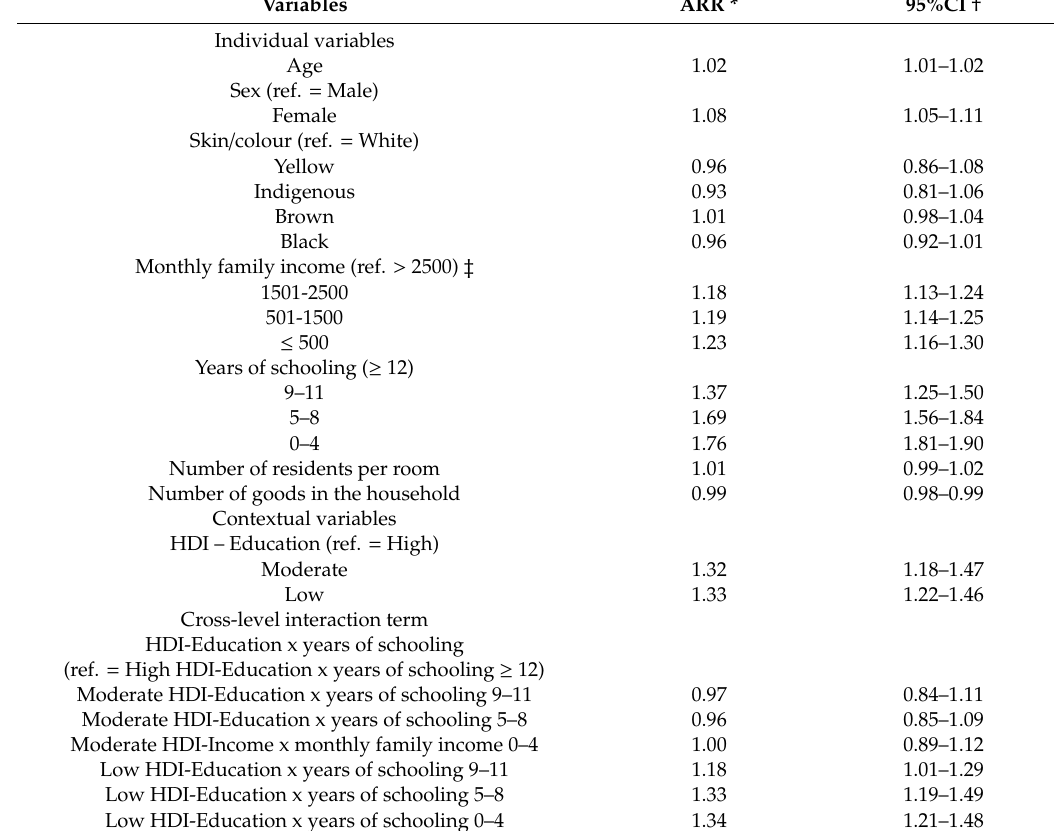
Table 4. Adjusted associations of HDI-Education (contextual factor), individual characteristics with tooth loss among elderly people determined by multilevel negative binomial regression.